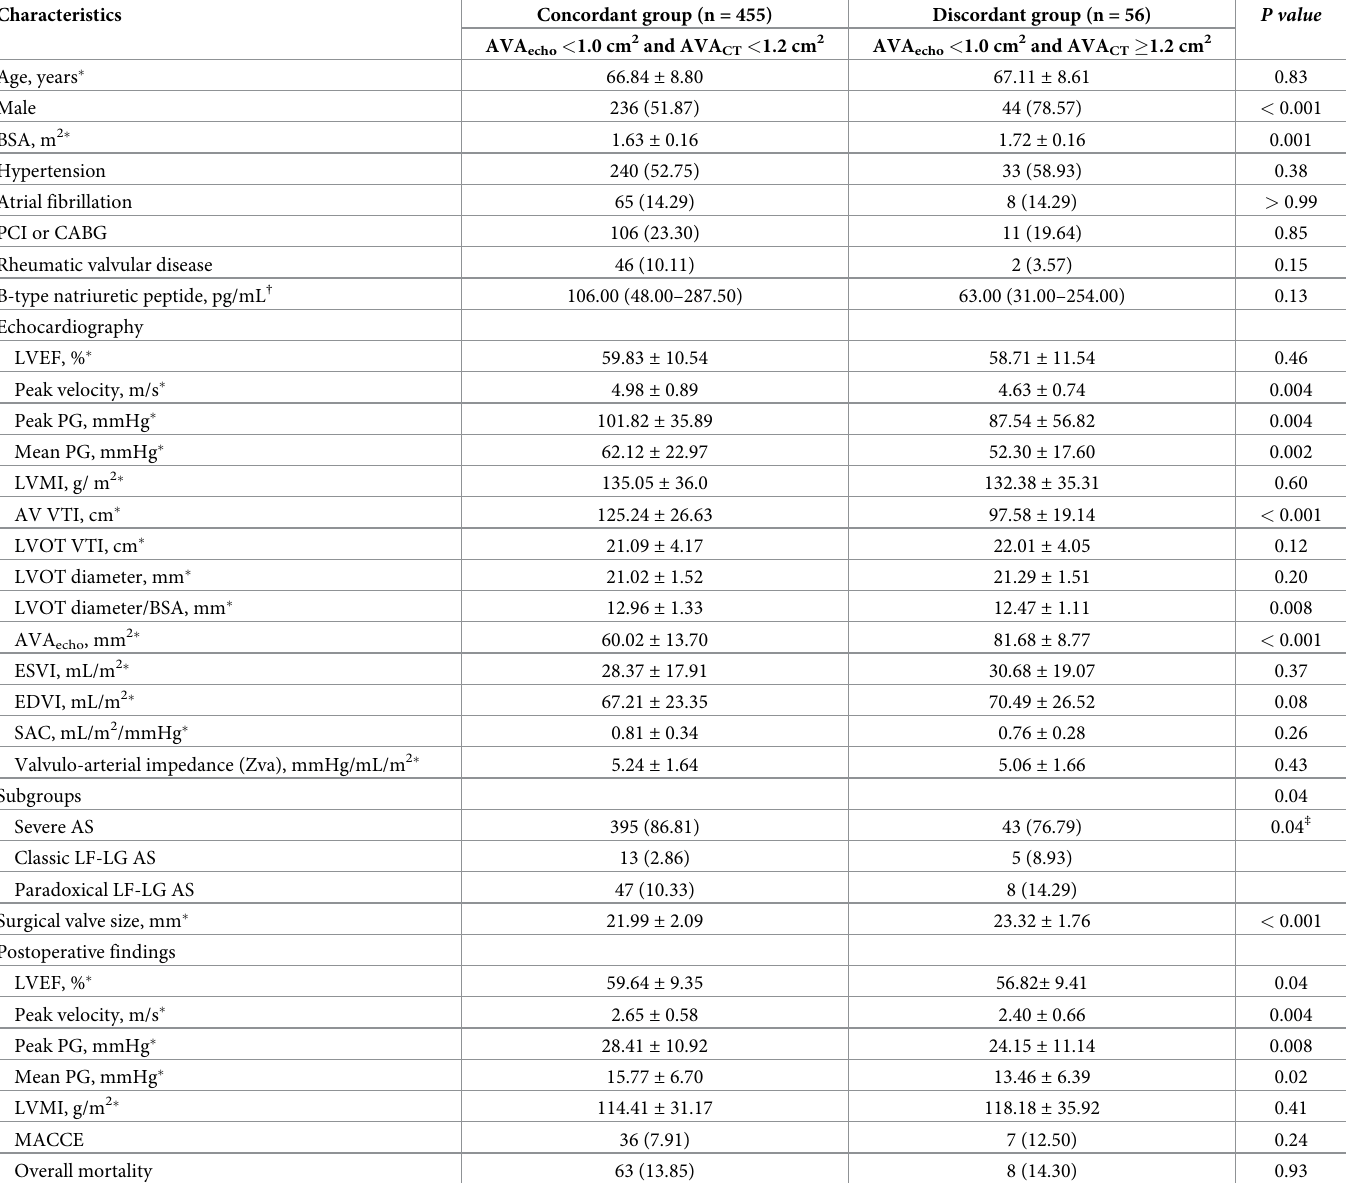
Table 2. Clinical and echocardiographic characteristics of concordant and discordant groups between AVA values measured by echocardiography and CT in severe AS.